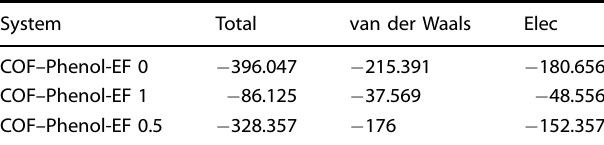
Fig. 2 The interaction energy between phenol molecules and COFs under an electrical fi eld with different strengths and zero- fi eld. The error bars represent the standard deviations of the